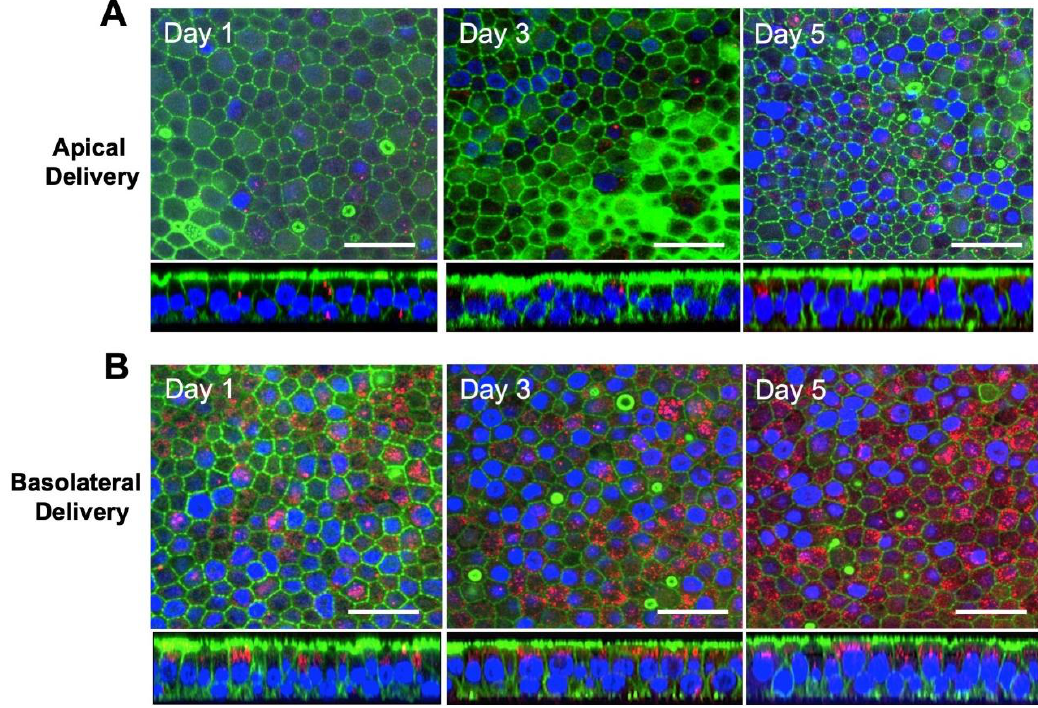
Figure 2. Exosomes can be delivered to well-di ff erentiated HAE. Exosomes (5 µ g) were labelled with CellMask Deep Red Plasma Membrane stain and applied apically ( A ) or basolaterally ( B ) to HAE for 4 h. HAE were fixed, permeabilized, and then stained for F-actin (green) and nuclei (blue). HAE were examined by confocal microscopy for internalization of exosomes at the indicated time points. Scale bar = 50 µ